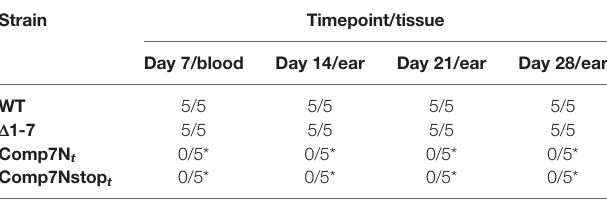
TABLE 4 | Infectivity of in trans complemented strains in SCID mice. Strain